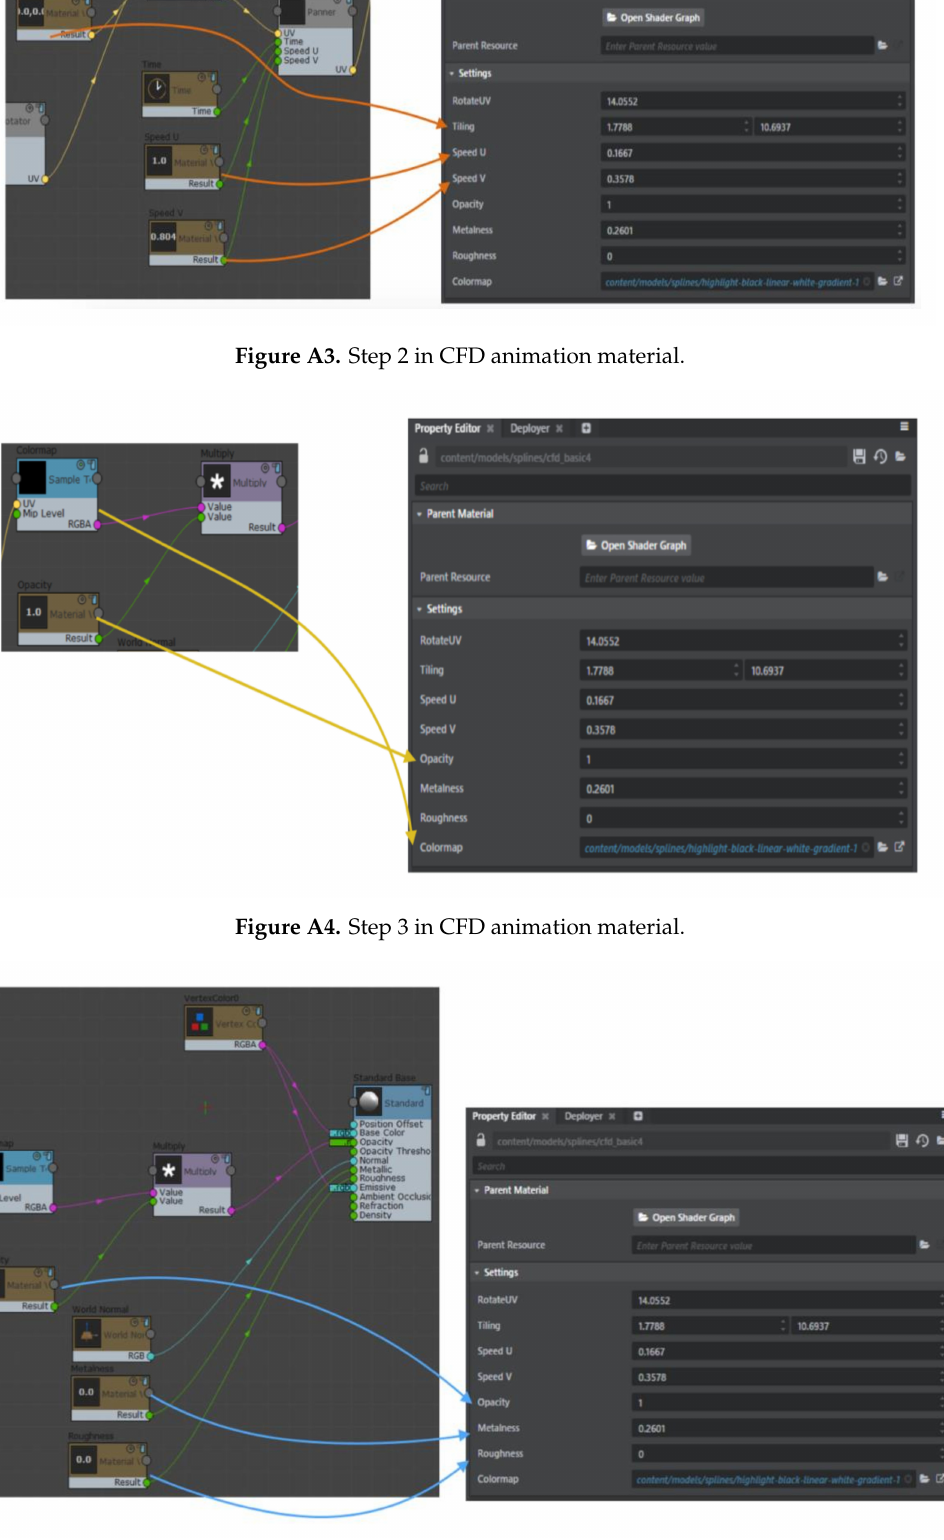
Figure A5. Final plug-in in CFD animation